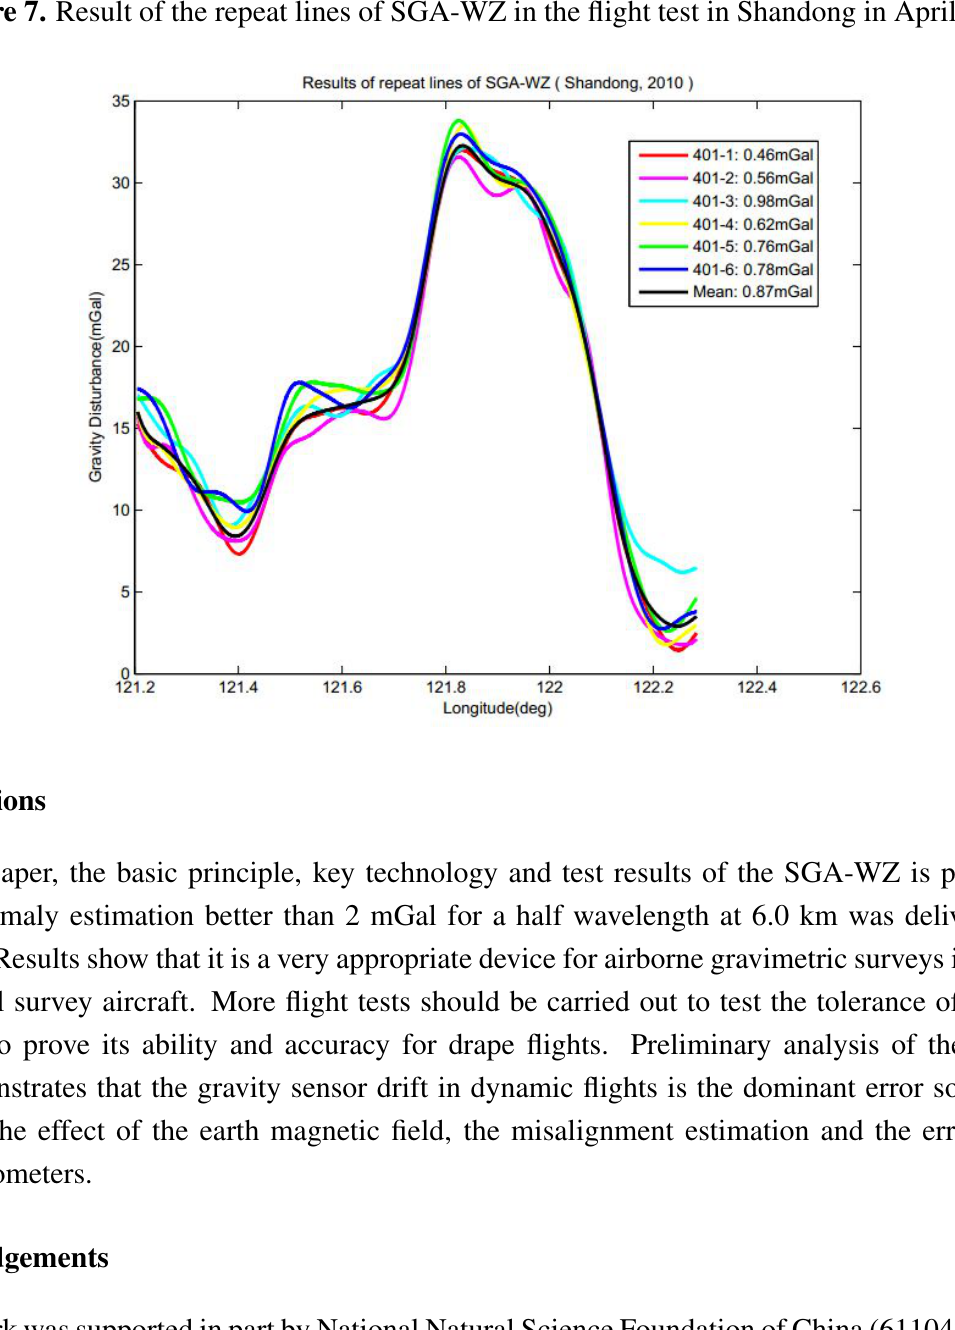
Figure 7. Result of the repeat lines of SGA-WZ in the flight test in Shandong in April